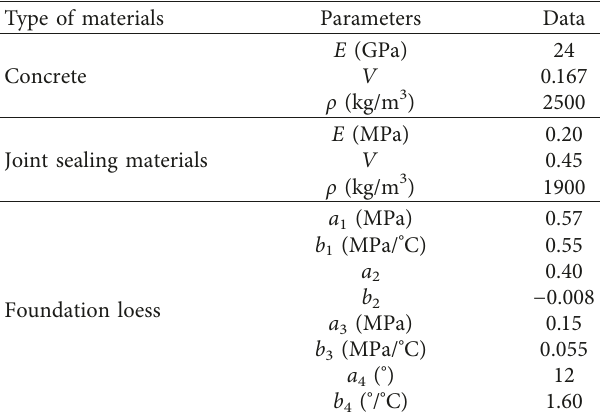
Figure 13: In situ measured ground water content and temperature. Table 3: Mechanical properties of materials in